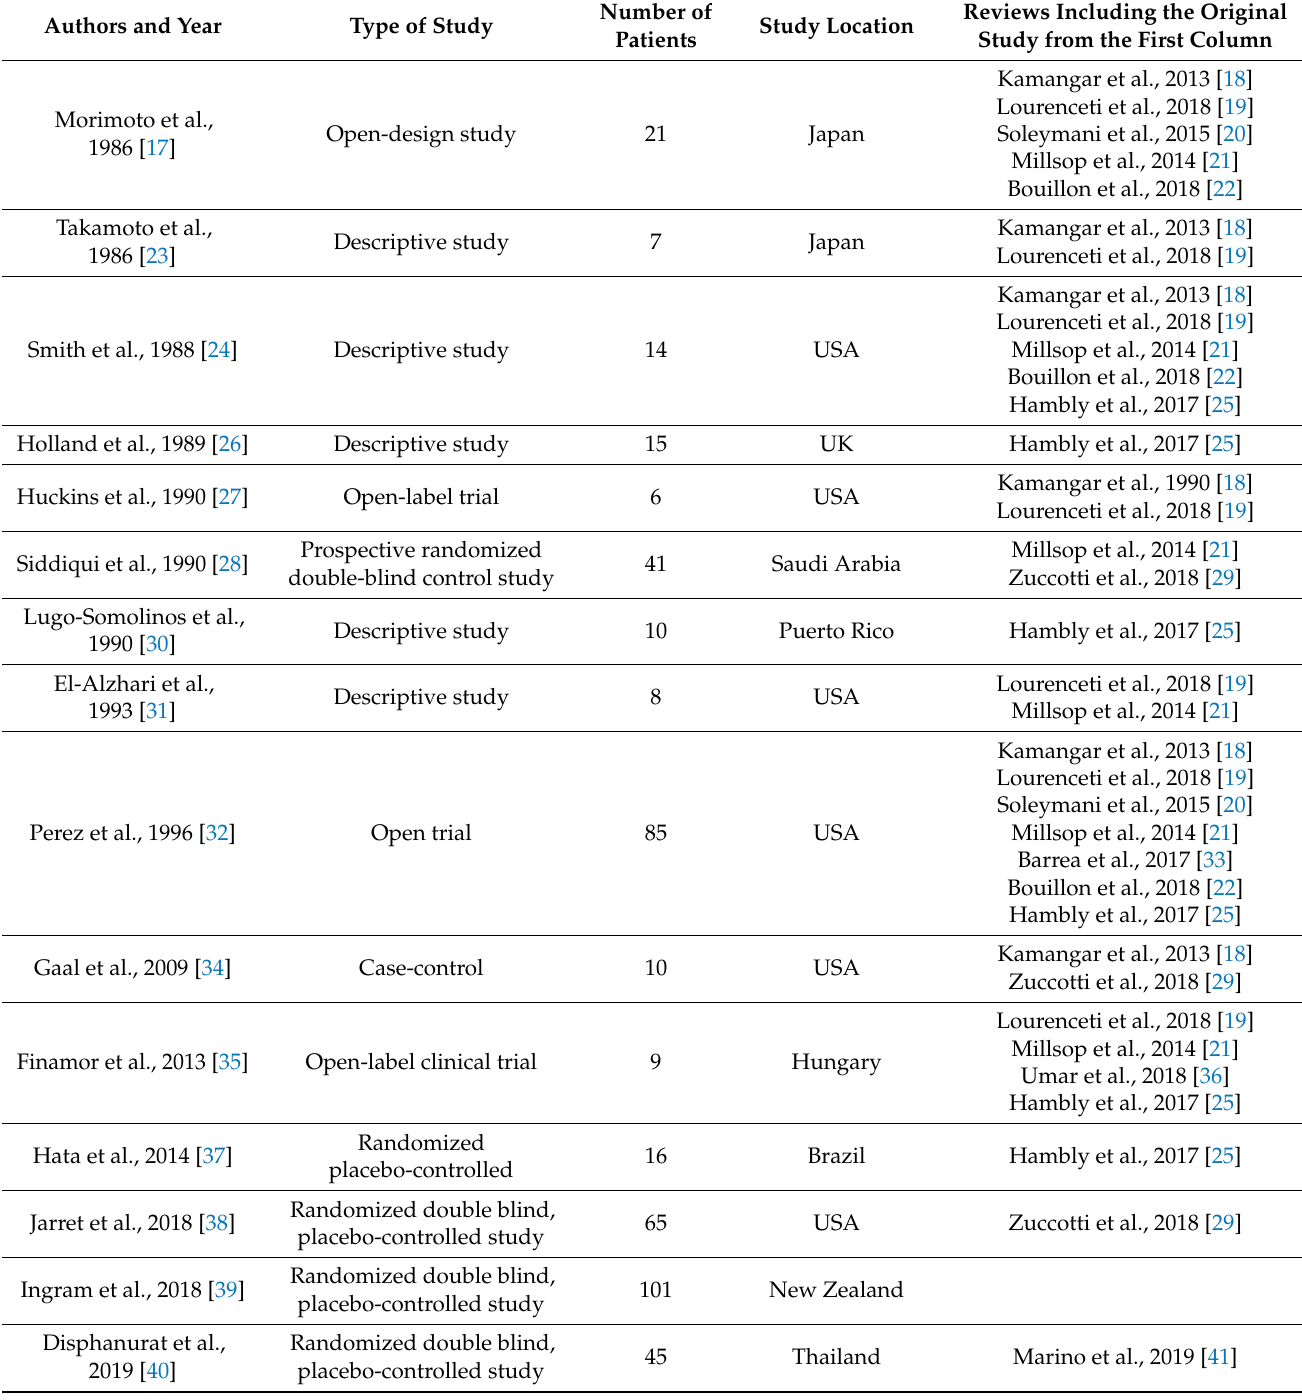
Table 1. The characteristics of the original studies included in the analyzed